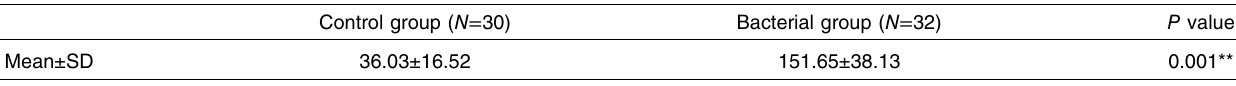
Table 5 Comparison between mean values of serum procalcitonin in the bacterial and control groups